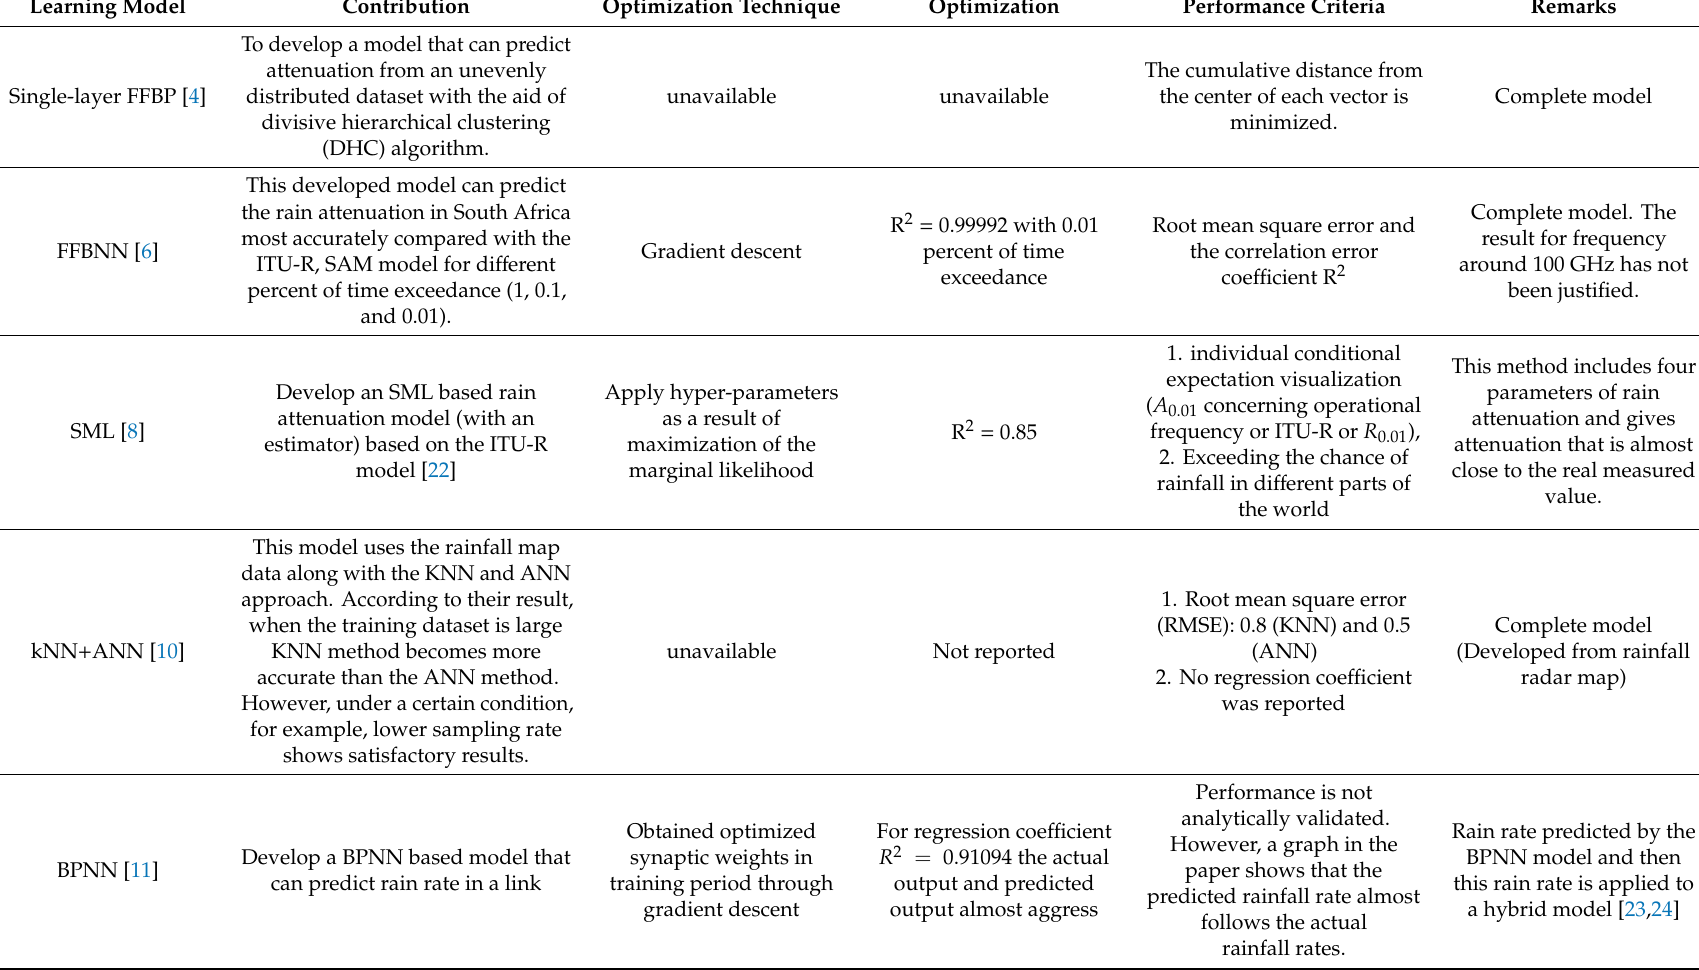
Table 4. Contributions, optimization, and evaluation criteria of LARA